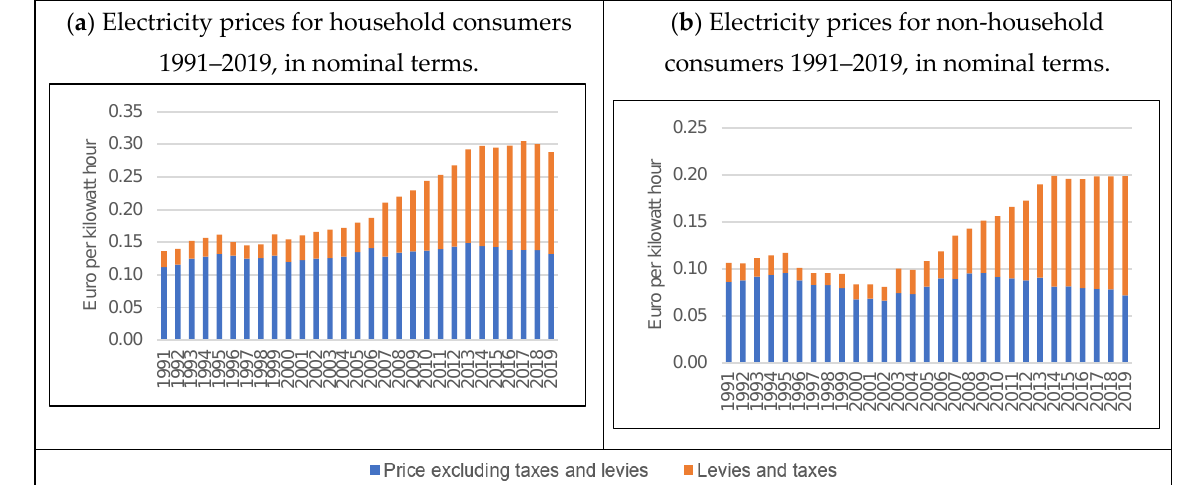
Figure 3. Evolution of the tax burden on electricity prices in Germany from 1991 to 2019. Source: own calculations based on data from Eurostat.